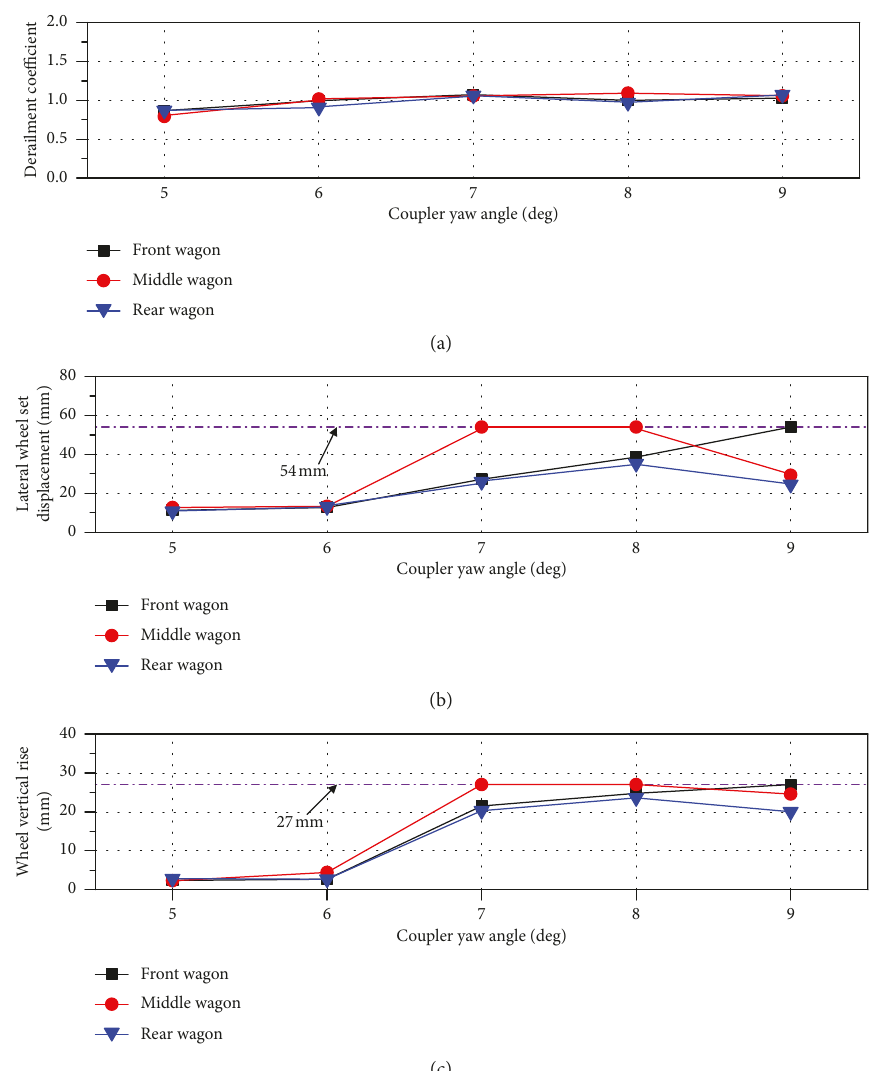
Figure 17: Effects of coupler yaw angle on (a) derailment coefficient, (b) lateral wheelset displacement, and (c) wheel vertical